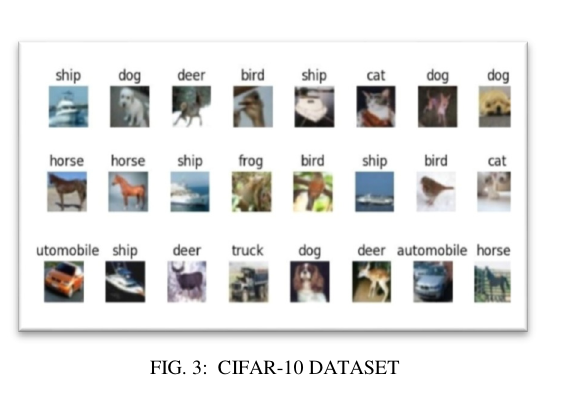
FIG. 3: CIFAR-10 DATASET